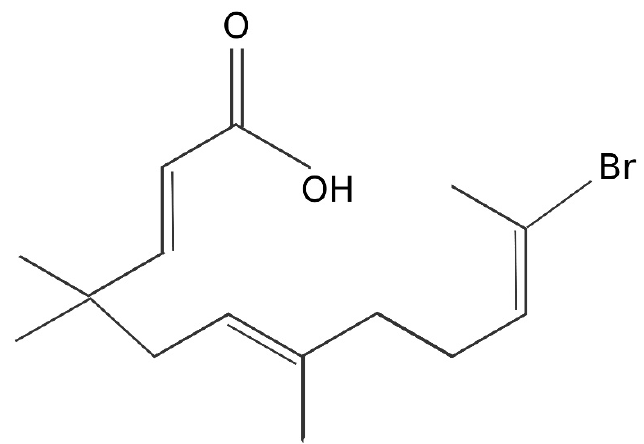
Figure 1. Structure of Zerumbone Ring Opening Derivative 2.